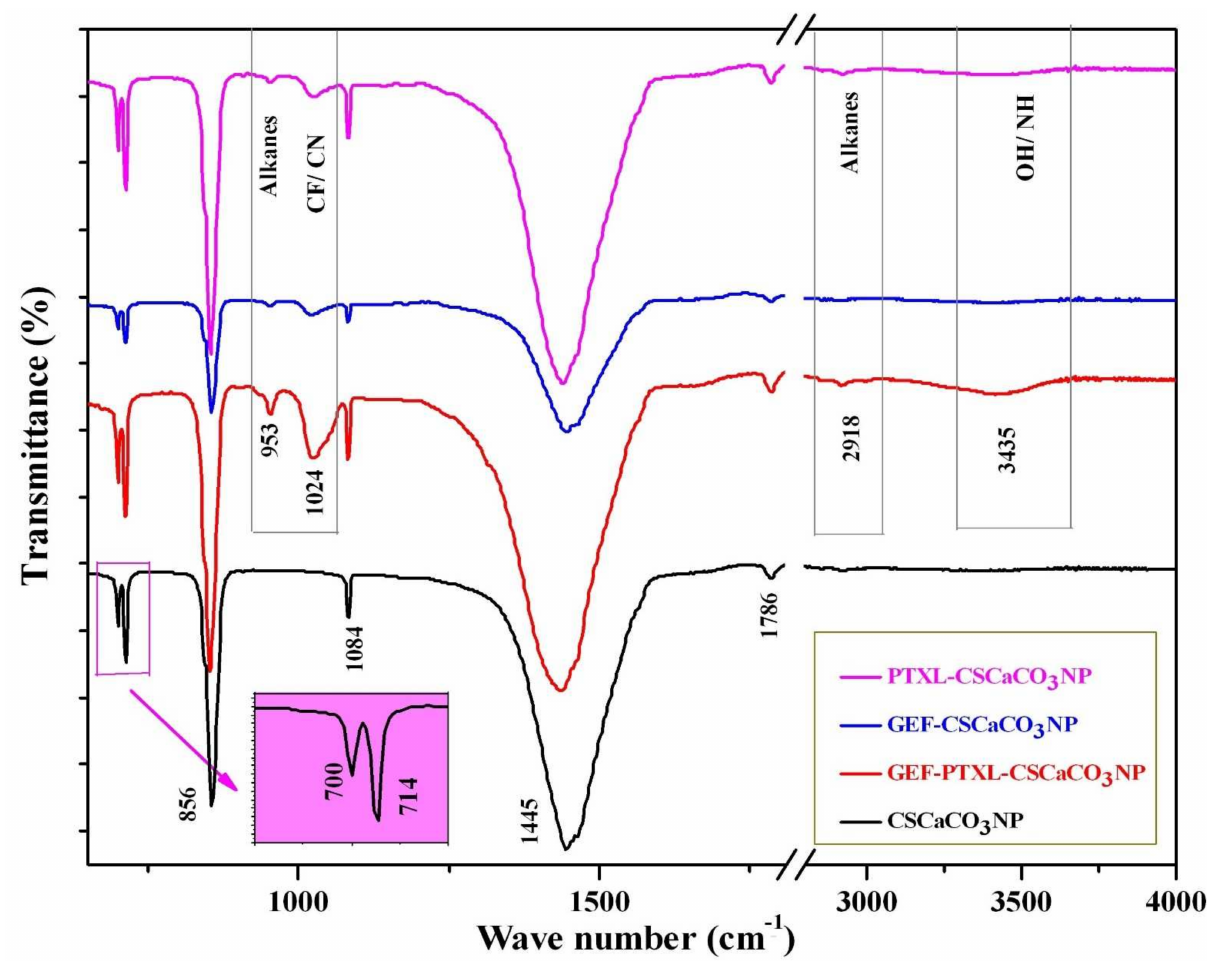
Figure 5. Fourier-transform infrared spectroscopy FTIR patterns of CSCaCO 3 NP ( y -axis: 15–100%, corresponding to the lowest point of curve and the highest), GEF-PTXL-CSCaCO 3 NP ( y -axis: 6–100%, corresponding to the lowest point of curve and the highest), GEF-CSCaCO 3 NP ( y -axis: 10–100%, corresponding to the lowest point of curve and the highest), and PTXL-CSCaCO 3 NP ( y -axis: 5–100%, corresponding to the lowest point of curve and the highest). The insert shows the doublet ν 4 the peaks (Pink shaded box), the newly formed peaks are indicated with the grey box (break in x -axis: 1810–2800 cm − 1